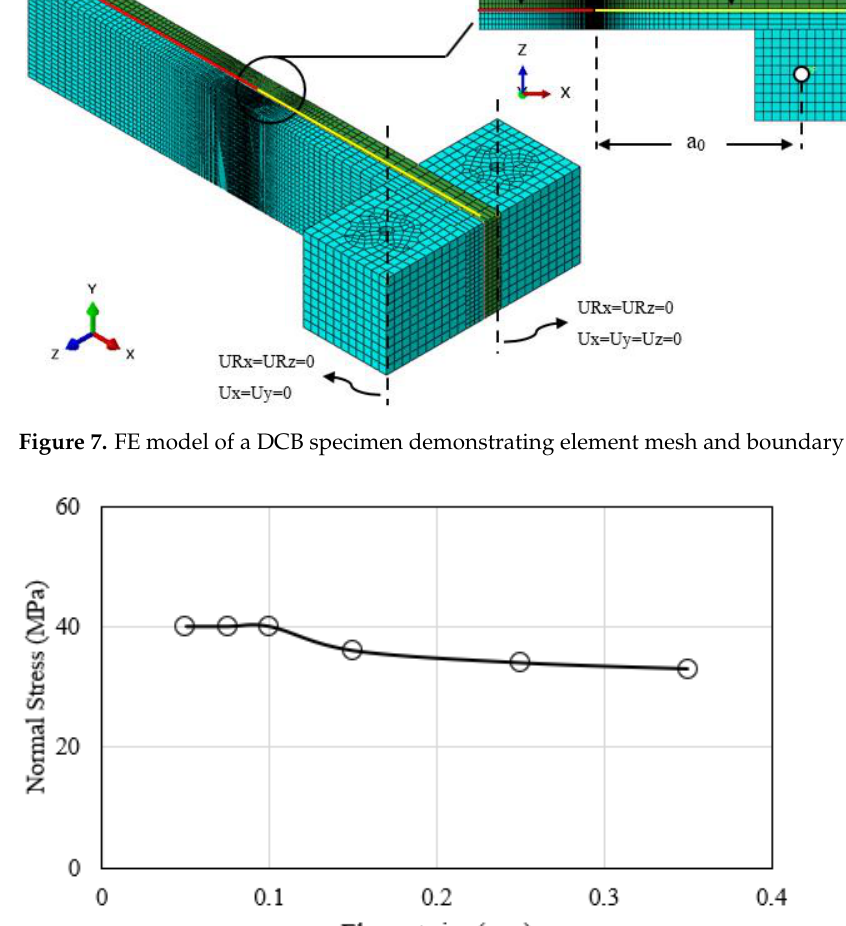
Figure 8. Mesh convergence analysis for the interface crack